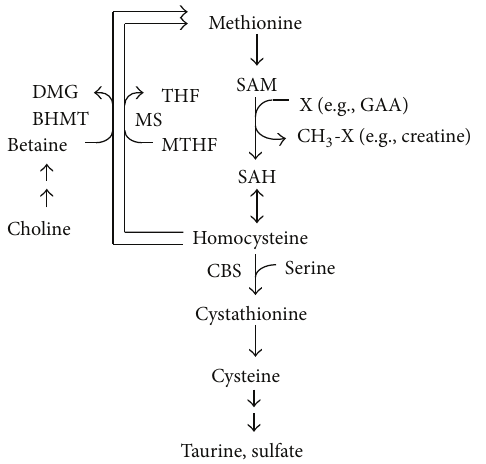
Figure 1: Metabolism of methionine and